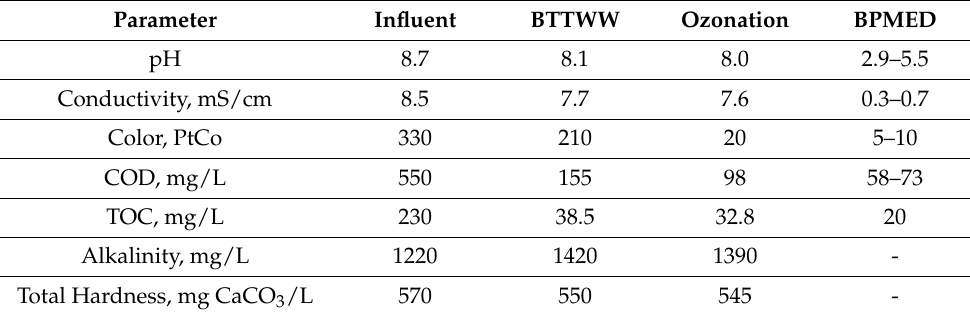
Table 3. Characterization of textile wastewater influent, effluent and post-ozonation